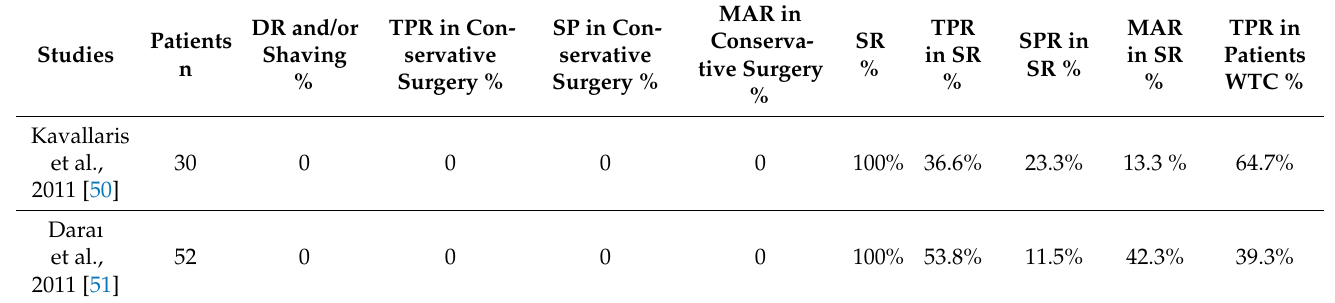
Table 4. PR in women who underwent conservative surgery (shaving and/or discoid resection) or segmental